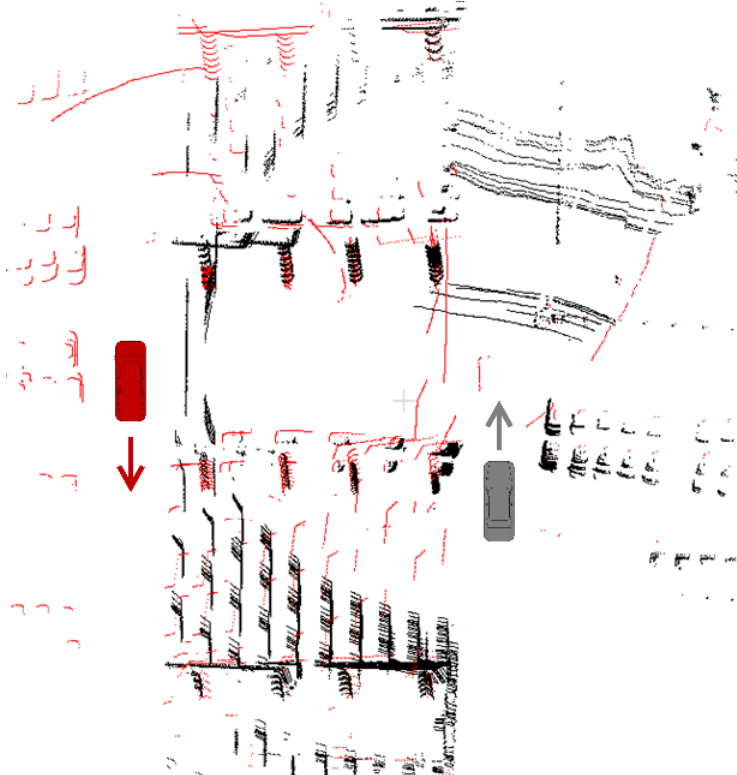
Figure 6. The LiDAR point clouds of the window occupancy likelihood map (OLM) of vehicle 1 ( black ) and the current laser scan of vehicle 2 ( red ) at one epoch. The black vehicle represents vehicle 1 and the red vehicle is vehicle 2.